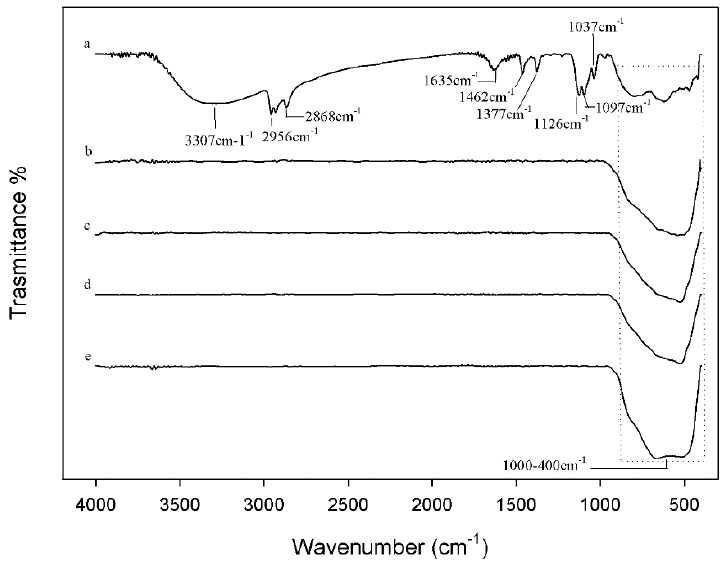
Figure 5. FTIR of ( a ) TiO 2 -1; ( b ) TiO 2 -2; ( c ) TiO 2 -3; ( d ) TiO 2 -4; ( e ) TiO 2 -5.